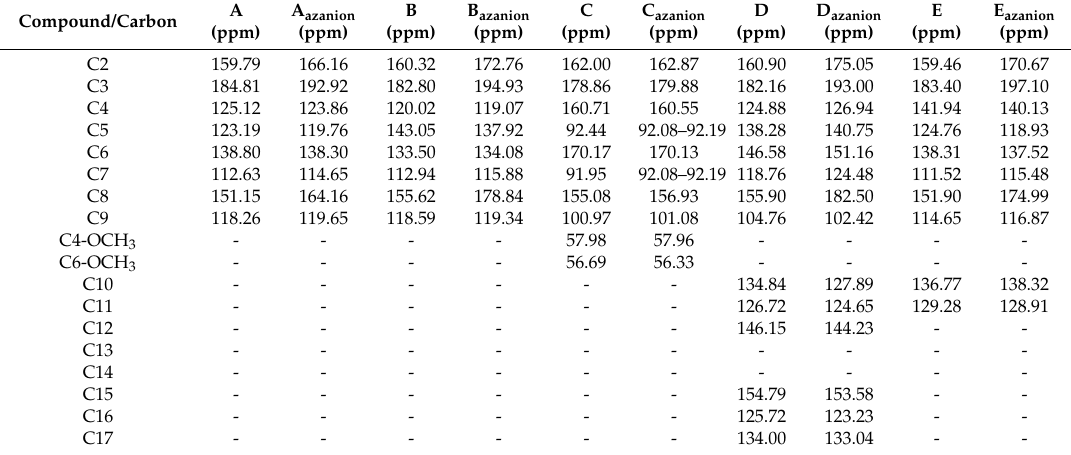
Table 5. Chemical shifts of the A – E isatin derivatives and their azanions in 13 C-NMR in DMSO.